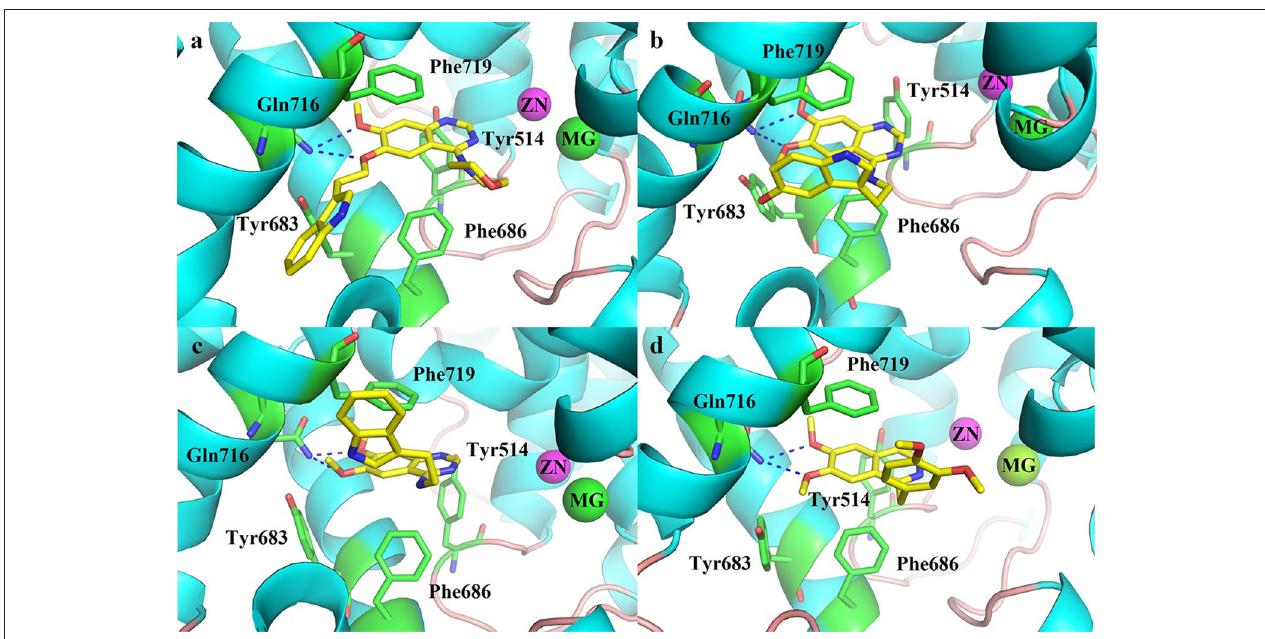
FIGURE 3 | Docked conformation of (a) compound 8a , (b) compound 11e , (c) compound 11a in complex with PDE10A and crystal structure of (d) papaverine in complex with